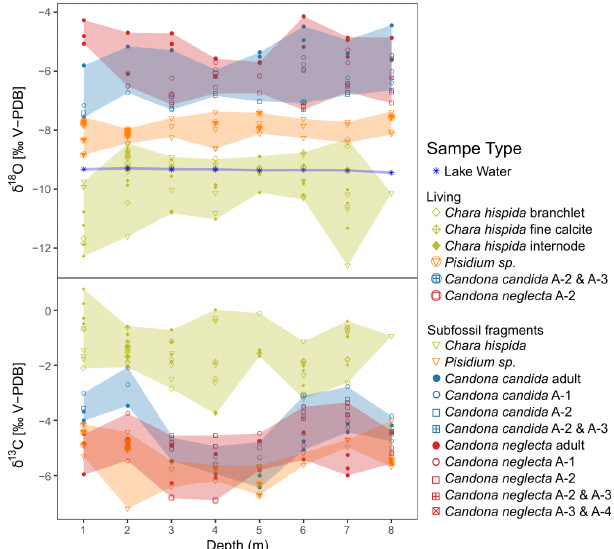
Figure 9. Interspecies and intraspecies variations in the isotopic composition ( δ 18 O and δ 13 C) of biogenic carbonates sampled along a transect in Lake Locknesjön at water depths from 1 to 8m. The colors indicate the species, and the shaded areas represent the ranges of their δ -values. The symbols represent different sample types (as in Fig. 7 for Chara hispida and as in Fig. 8 for ostracods). The blue asterisks represent δ 18 O of water samples taken at the same locations. The values of lake water are reported in ‰ relative to